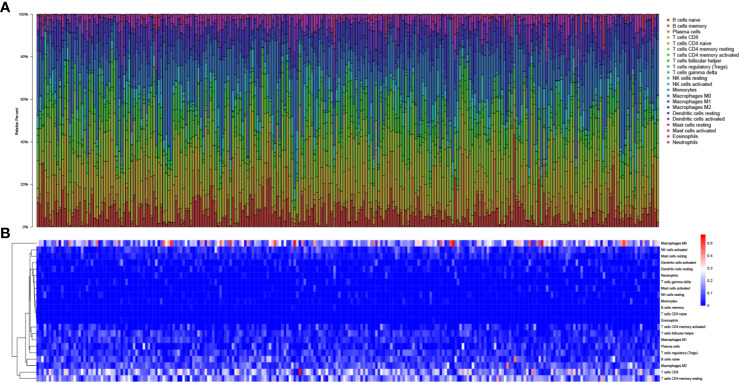
The landscape of tumor-infiltrating immune cells. (A) Bar plot of the fraction of tumor-infiltrating immune cells; (B) Heat map of the fraction of tumor-infiltrating immune cells.